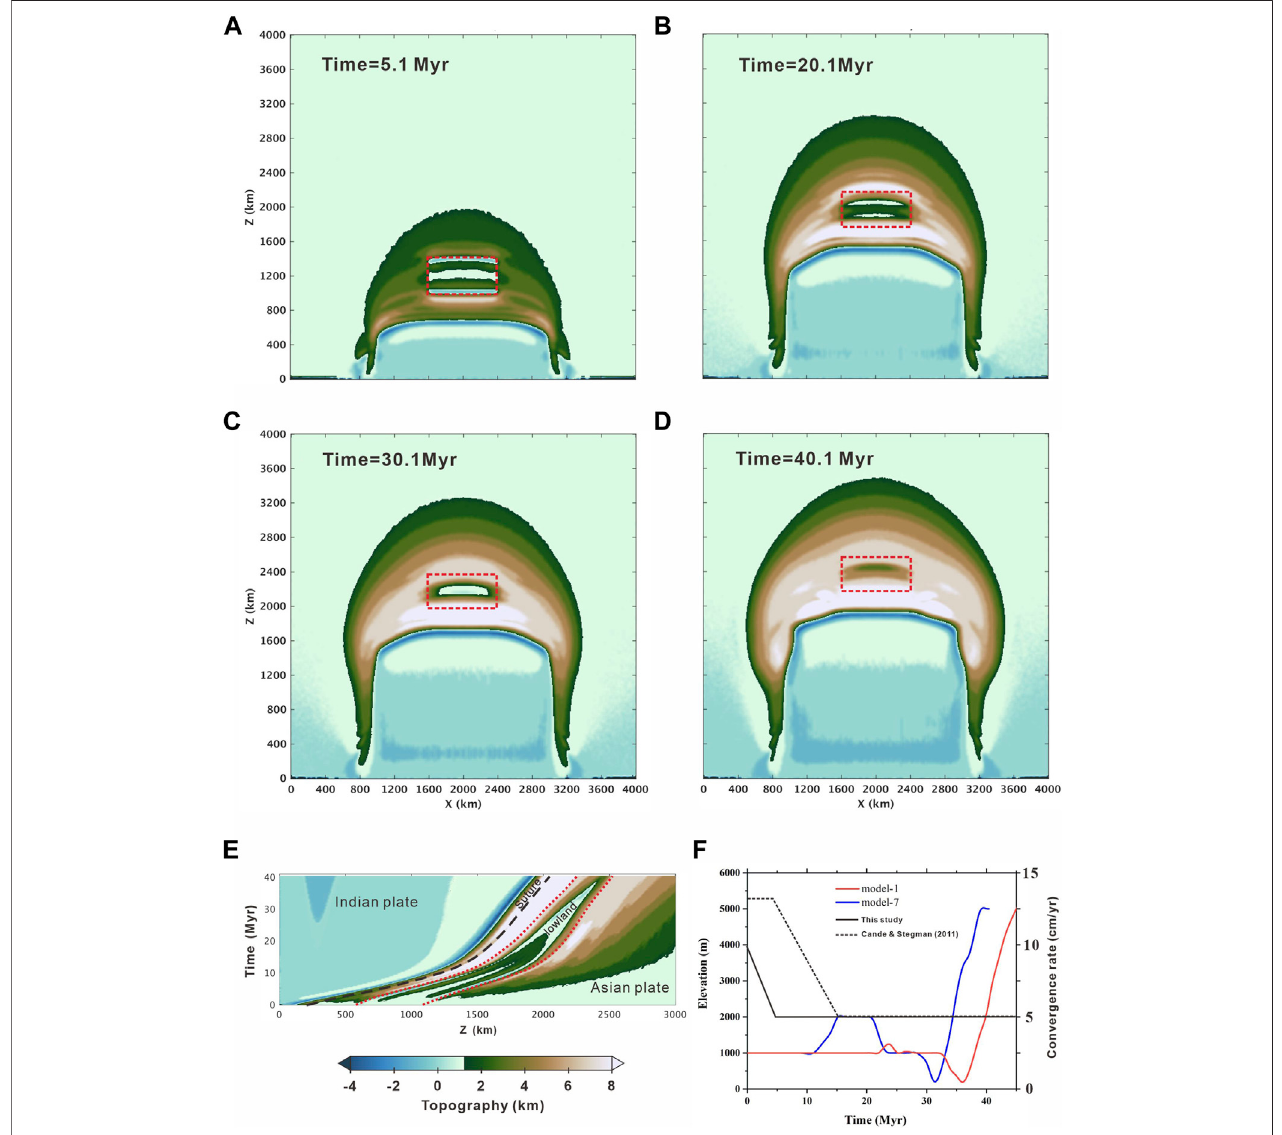
FIGURE 11 | Topographic evolution of the model-7 ( Table 2 ). Snapshots showing the surface topography at (A) 5.1 Myr (B) 20.1 Myr (C) 30.1 Myr, and (D) 40.1 Myr (E) display the topographic evolution with time along section x = 2,000 km. (F) showing the difference of uplift history of center point C between the reference model (red line) and model-7 (blue